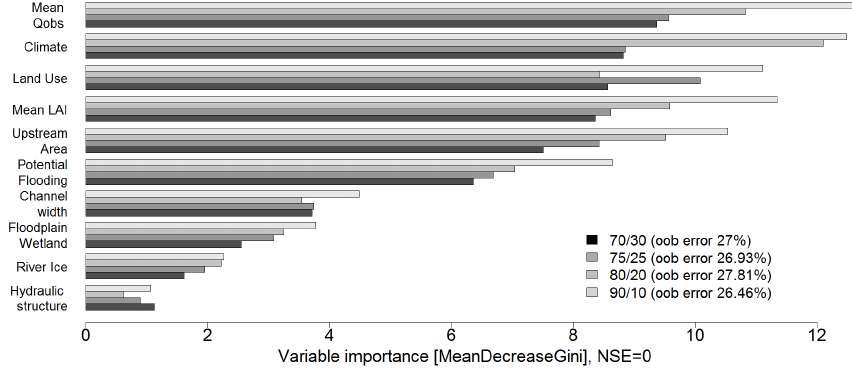
Figure 12. Average variable importance of 200 runs using the RF methodology. The Nash–Sutcliffe score was chosen as a quality index for categorising the stations as true (good predictive) or false (poor predictive). With a threshold of NSE = 0, we have about 50% of the stations above and 50% below that value. Results are shown for the different training and test groups. For all the test groups and runs, the average highest variable importance was obtained for mean observed discharge, climatic region, land cover/mean LAI and upstream catchment area, and the lowest for dam/hydraulic structure presence and river